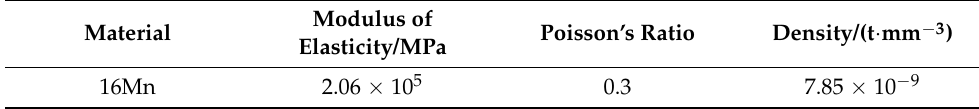
Table 2. Material parameters of the excavator beam.